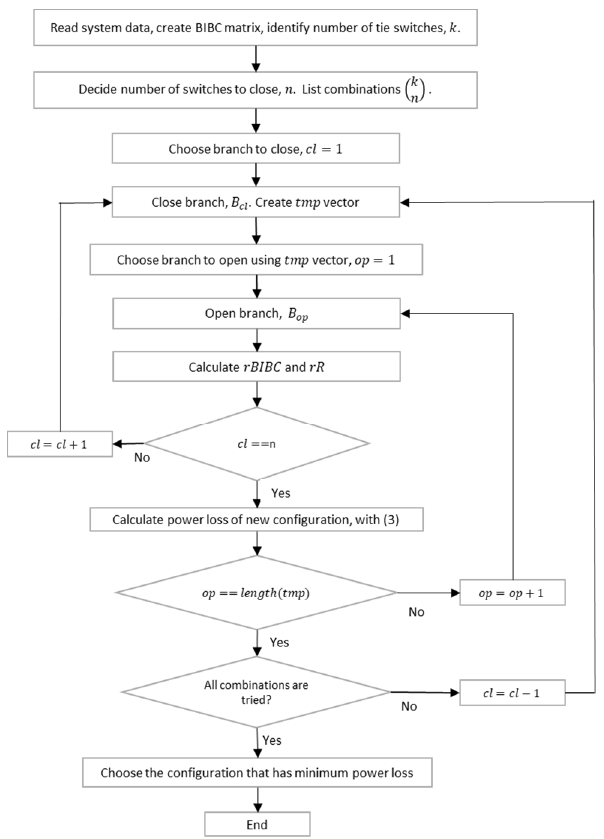
Figure 5. Flowchart of grid search algorithm.